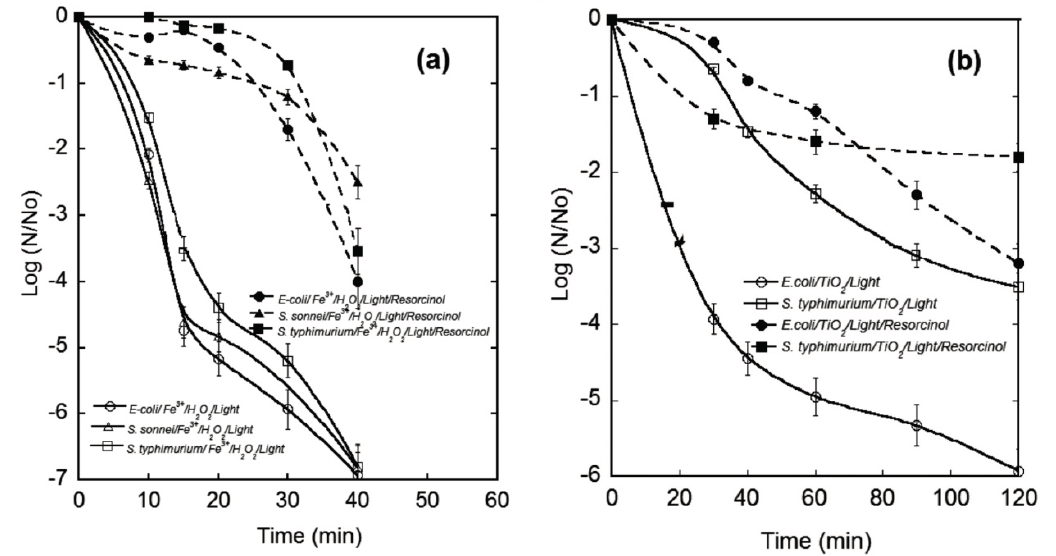
Figure 1. Effect of resorcinol (10 mg/L) on inactivation of bacteria in ( a ) photo-Fenton and ( b ) TiO 2 photocatalytic processes. Solar simulator light intensity: 1000 W/m, initial bacteria concentration: 10 6 CFU/mL. Photo-Fenton parameters: Fe 3+ : 1 mg/L, and H 2 O 2 : 60 mg/L, initial pH = 5.0. TiO 2 photocatalysis: TiO 2 concentration: 1.0 g/L. Reproduced from